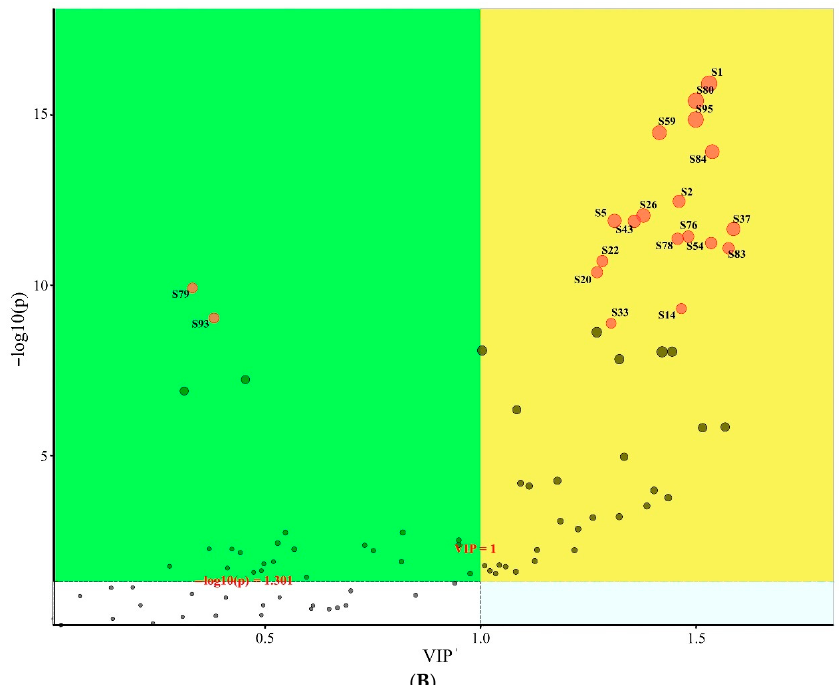
Figure 3. ( A ) PCA results of volatile compounds in MPR samples with different processing. C: Control group; T1: test group 1 (using the improved technology of Sichuan spicy flavor formula); T2: test group 2 (using the improved technology of halogen flavor formula). The data are from 6 repeats of each experimental group. ( B ) PLS-DA diagram of 115 volatile compounds. C: Control group; T1: test group 1 (using the improved technology of Sichuan spicy flavor formula); T2: test group 2 (using the improved technology of halogen flavor formula). The red circles (VIP > 1 and p < 0.05) are the volatile compounds that have changed significantly during the fermentation and different process of making MPR. The higher the VIP value is, the greater the difference. S1: Cyclopropane, ethyli-